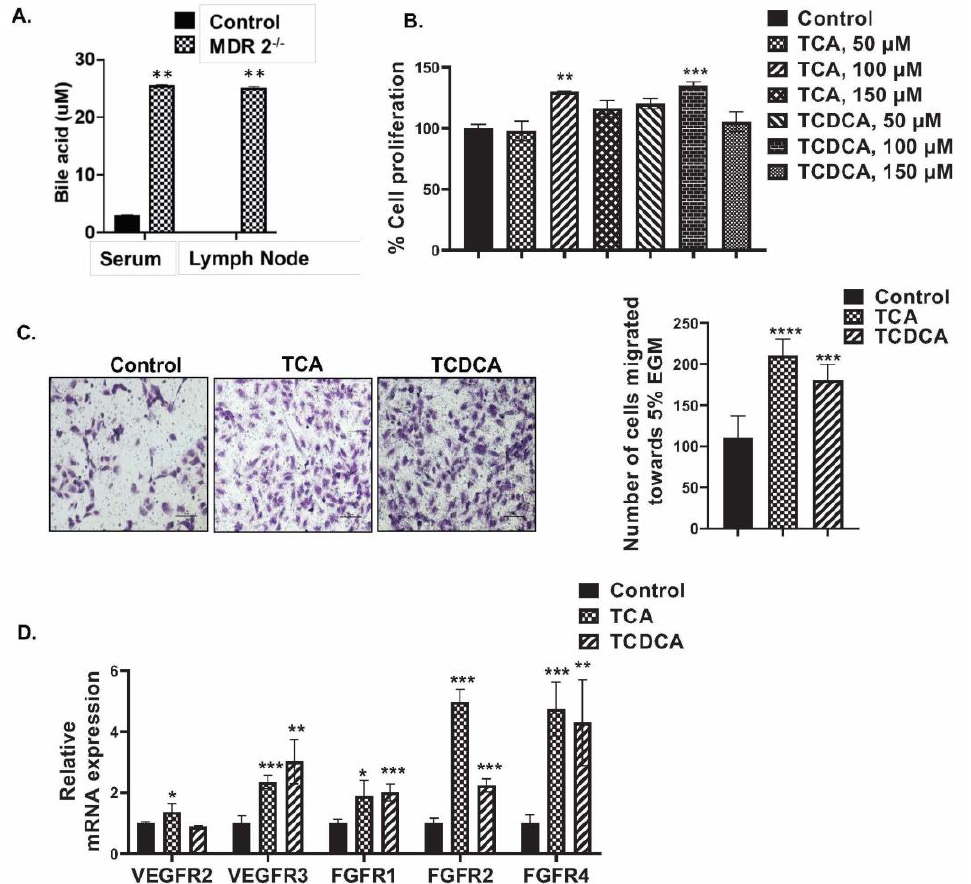
Figure 2. Elevated levels of BAs are found in lymph nodes of PSC mice and BAs induce activation of pro-lymphangiogenic mechanisms in vitro. ( A ) BA concentrations (in µM) in serum and lymph nodes of Mdr2 − / − mice. Values represent mean ± SD, n = 3. ( B ) Conjugated BAs induced HLEC proliferation was measured by XTT assay and data represented as % of cell proliferation. Values are represented as mean ± SD, n = 5 ( C ) TCDCA and TCA (100 µM)-induced migration of HLECs through the Transwell inserts towards 5% FBS containing EGM (5% EGM) at 24 h. ( D ) TCDCA and TCA (100 µM)-induced mRNA levels of lymphangiogenic growth factor receptors in 5% EGM for 24 h were measured by real time PCR assay. Values represent mean ± SD, n = 3. Statistical analysis was done by ANOVA followed by Fishers LSD. *, **, ***, and **** represents p ≤ 0.05, p ≤ 0.01, p ≤ 0.001, and p ≤ 0.0001, respectively, as compared to control.